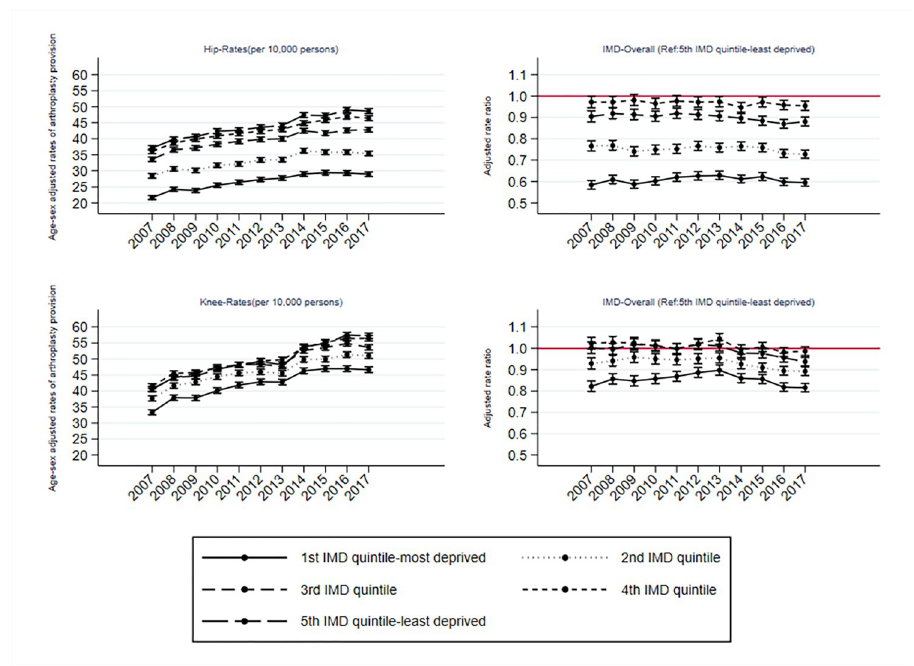
Fig 1. Rates and RRs with 95% confidence intervals of joint replacement provision by area of residence deprivation level adjusted for age, sex, and area of residence (LSOA). IMD AU : AbbreviationlistshavebeencompiledforthoseusedinFigs 1 and 3 : Pleaseverifythatallentriesarecorrectlyabbreviated : , Index of Multiple Deprivation; LSOA, Lower Layer Super Output Area; RR, rate